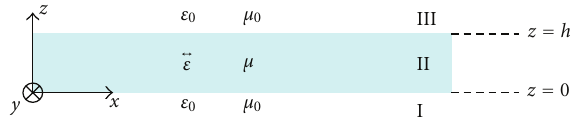
Figure 1: Schematic illustration of the geometry of the system under considering shows the thickness ( h ) of the anisotropic (isotropic) layer and the coordinate